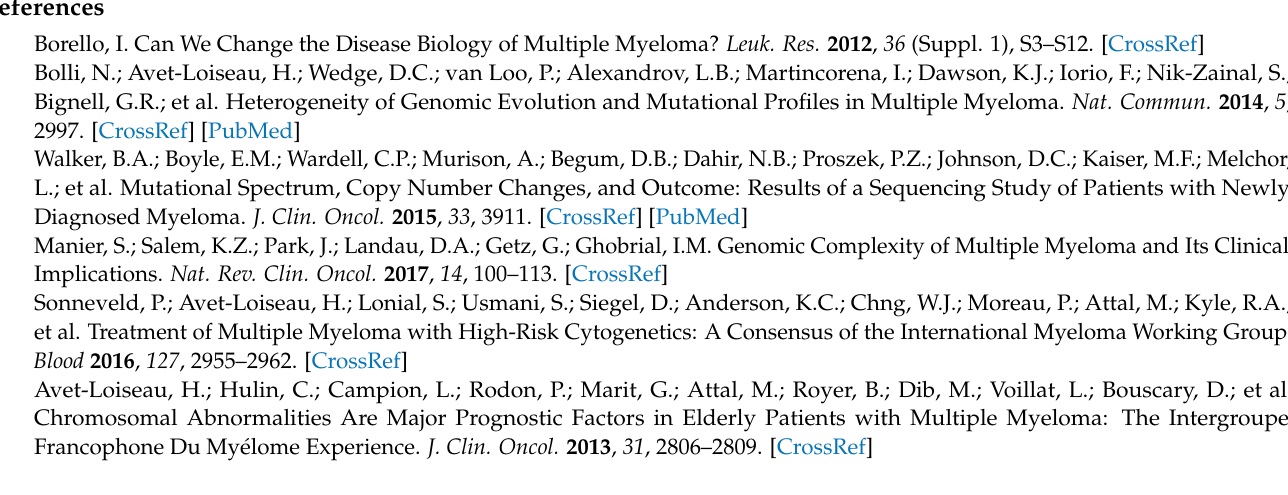
statistics; Table S2: Raw sequencing statistics for each sample. (A) Panel data. (B) WES data; Table S3: SNVs and indels identified in MM patients; Table S4: Comparative table between FISH and NGS results, related to FISH probe locations; Table S5: IGH arrangement summary of PPCs; Table S6: IG rearrangements identified by using both MiXCR and Vidjil; Table S7: IG rearrangement identification comparative study; Table S8: Comparative mutational results from exome and panel data; Table S9: CNV events identified by panel and exome analysis across chromosomes 1 and 17; Table S10: Estimation of PPV, NPV, sensitivity, specificity and global